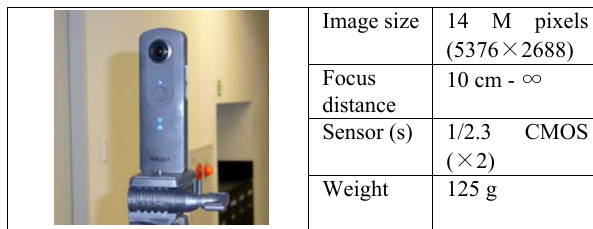
Figure 3. Panoramic camera (THETA S, RICOH)